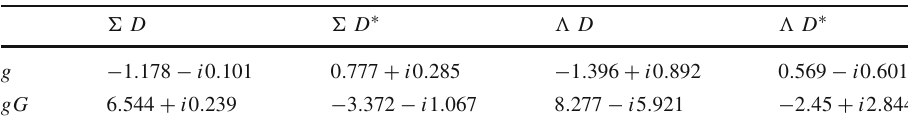
Table 2 Values of g and gG for the different channels for the resonance (cid:2) 0 c ( 2790 )( 1